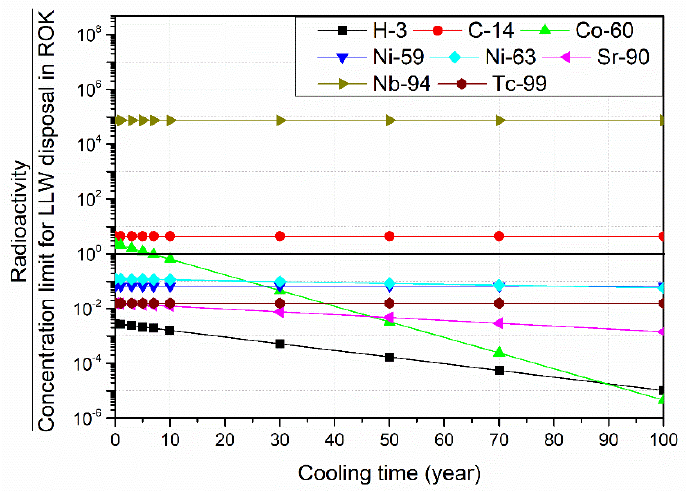
Figure 1. The ratio of radioactivity in the irradiated CANDU pressure tube after operating for 30 years to activity concentration limit for LLW disposal in ROK with cooling time.